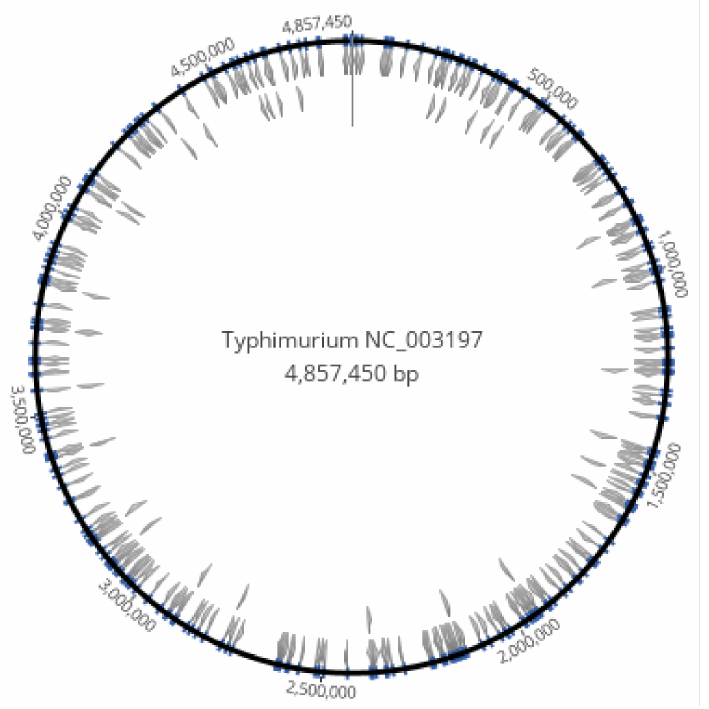
Figure 1. Locations of AT 8+mers in the genome of Salmonella enterica serovar Typhimurium LT2